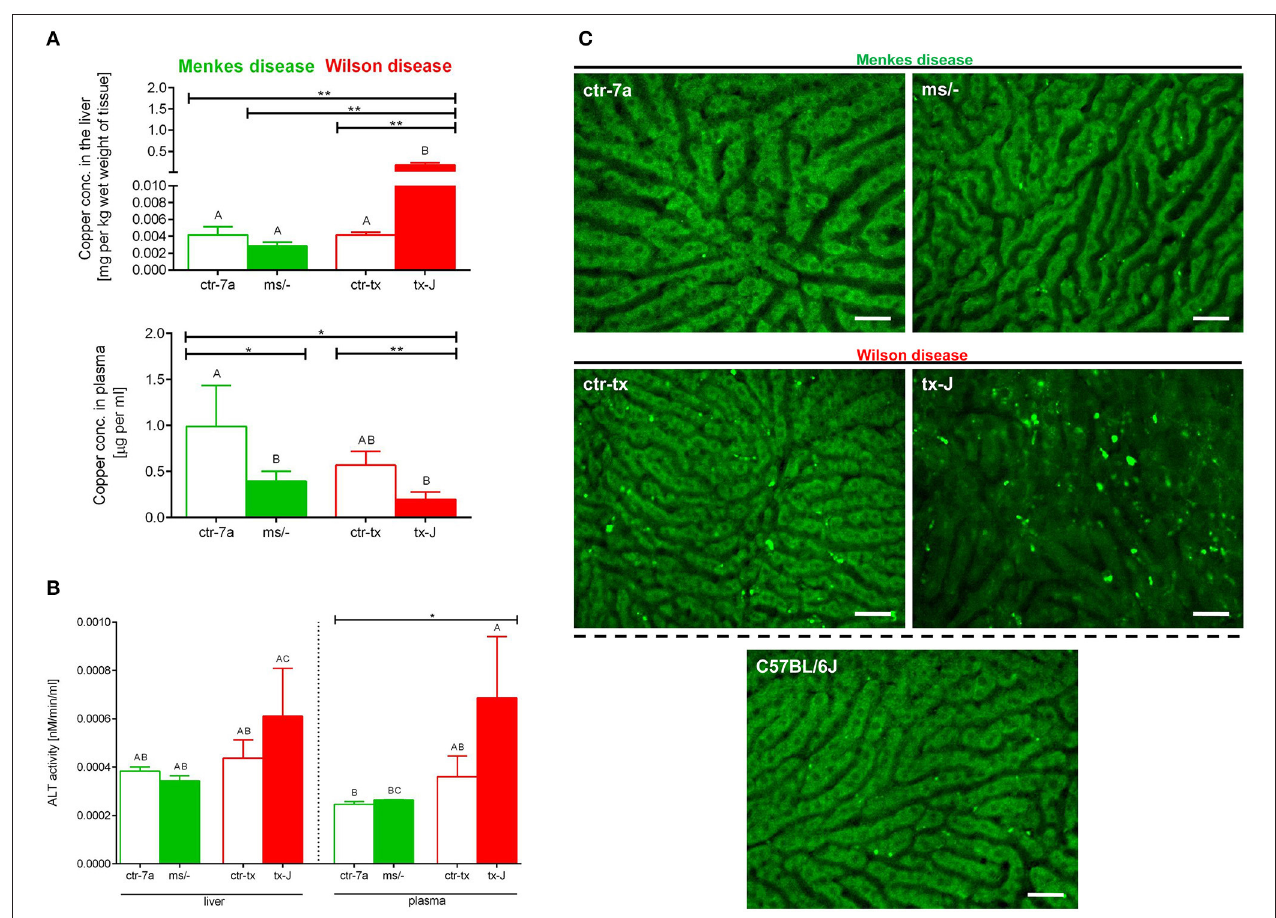
FIGURE 7 | Liver and plasma copper accumulation (A) and alanine transaminase (ALT; B ) levels estimated in mice with Wilson (tx-J) and Menkes ( ms / − ) diseases and their respective controls (ctr-tx and ctr-7a). Asterisks indicate significant differences using unpaired two-tailed Student’s t test (* P ≤ 0.05, ** P ≤ 0.01) and one-way ANOVA ( post hoc Bonferroni) test (different letters indicate statistically significant differences between groups). Condition of hepatocytes, visibility of sinusoids, and deposition of autofluorescent aggregates is shown on representative images of livers in (C) ; images of mice with Wilson and Menkes diseases are shown along with their controls and C57Bl/6J mice. No additional staining was performed, and only autofluorescent hepatocytes (green) were recorded in the GFP channel. Between the hepatocytes, sinusoids (black ducts) can be observed. The scale bar indicates 50 µ m.